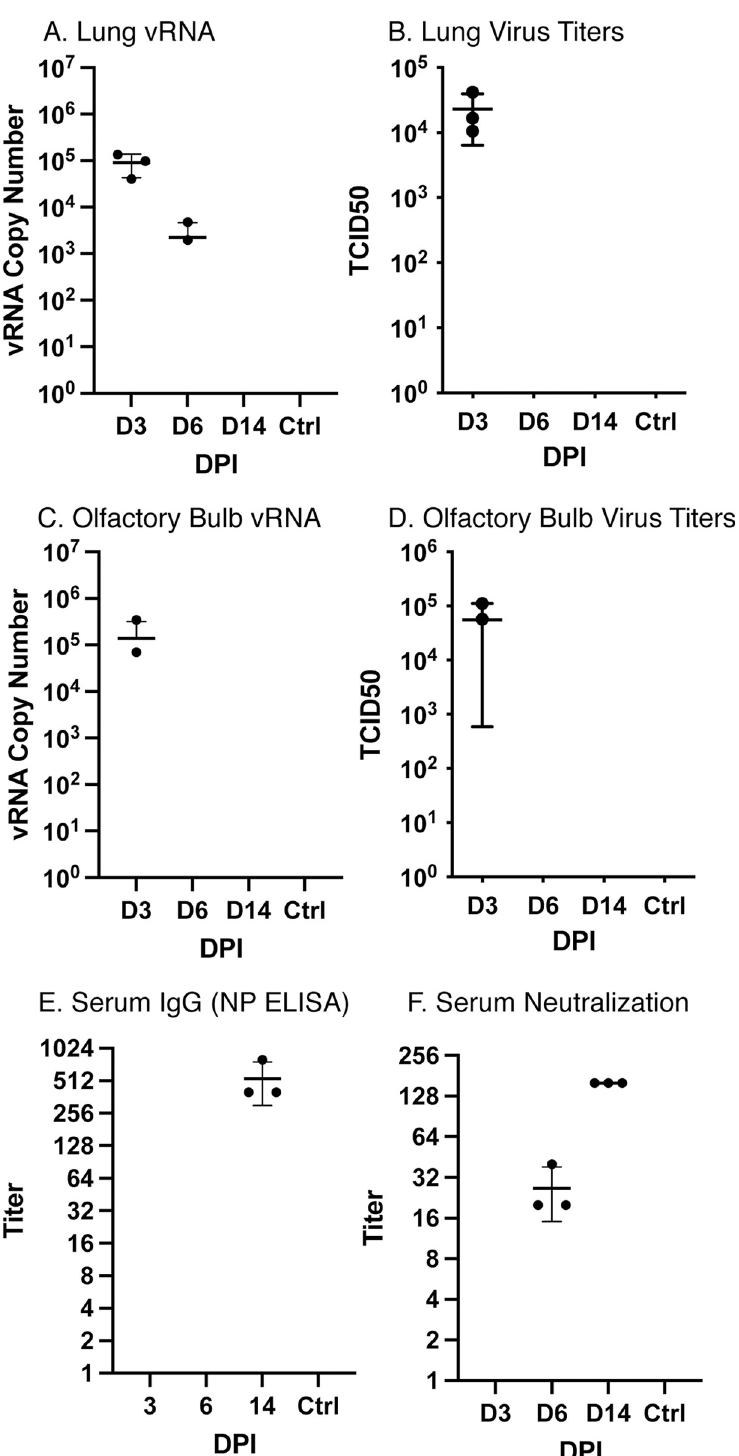
Fig 1. Infection and antibody response to SARS-CoV-2. (A) Viral RNA was detected in lungs of infected deer mice to day 6, and (B) virus was recovered only on day 3. (C) Two of three deer mice had detectable vRNA in their olfactory bulbs and (D) virus was isolated from each. (E) IgG antibodies were detected to nucleocapsid protein on day 14, (F) with neutralizing antibody detected on days 6 and 14. Each time point represents samples collected from 3 euthanized deer mice per group. Error bars represent the standard deviation of the mean and geometric mean antibody titers.